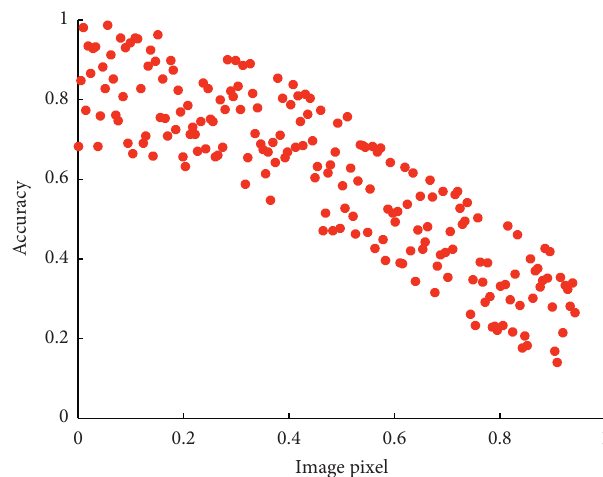
Figure 7: The relationship between image recognition accuracy and pixel value.